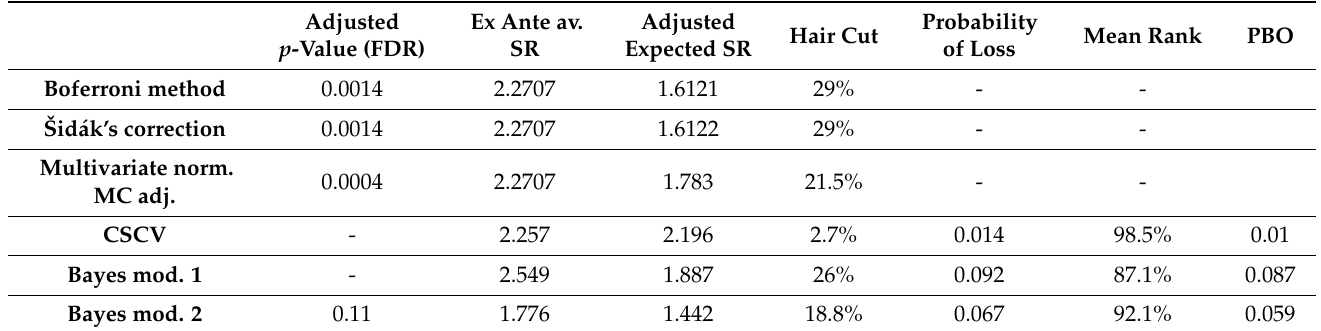
Table 2. Summary of the test results.